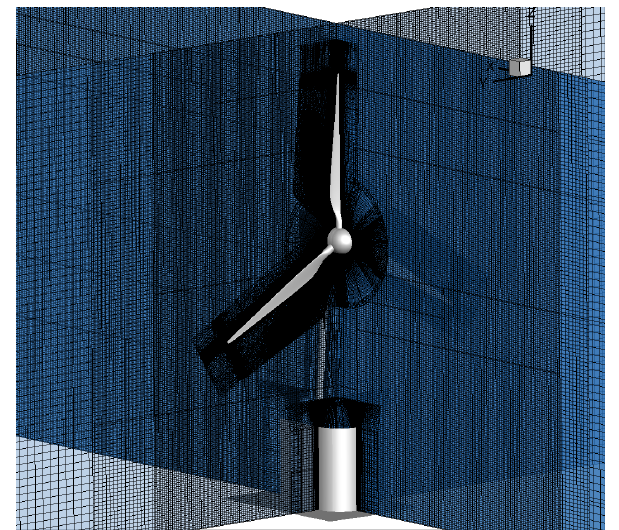
Figure 5. Numerical set-up of the fully resolved wind tur- bine